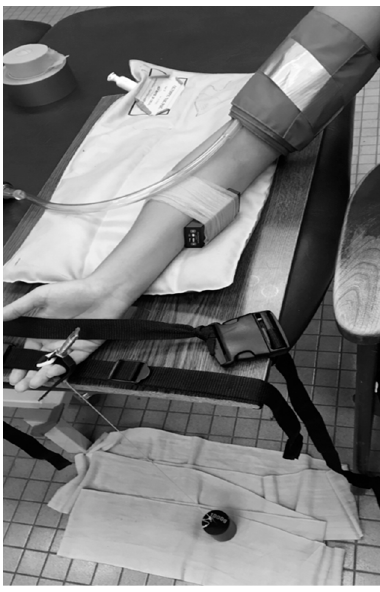
Figure 1. Experimental arrangement. The near-infrared spectroscopy (NIRS) device was placed in the medial (as shown) and lateral positions of the body of the forearm flexor muscles. A blood pressure cuff was placed proximal to the NIRS device. Manual exercise with a 1000 g weight was used to activate finger flexor muscles individually. Subjects were tested in a seated position with a pad under the elbow for support.